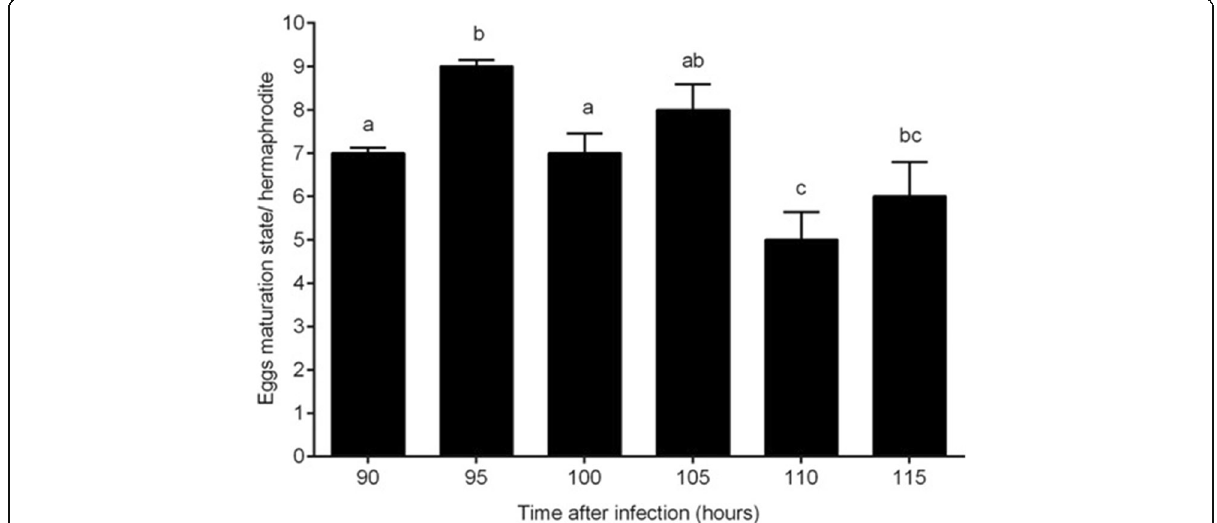
Fig. 2 Egg maturation stages isolated from H. indica SL0708 uterus. Significant differences ( p < 0.05) among times were established by Tukey post hoc tests and are represented by different letters among times. Mean ± SEM, ( n =